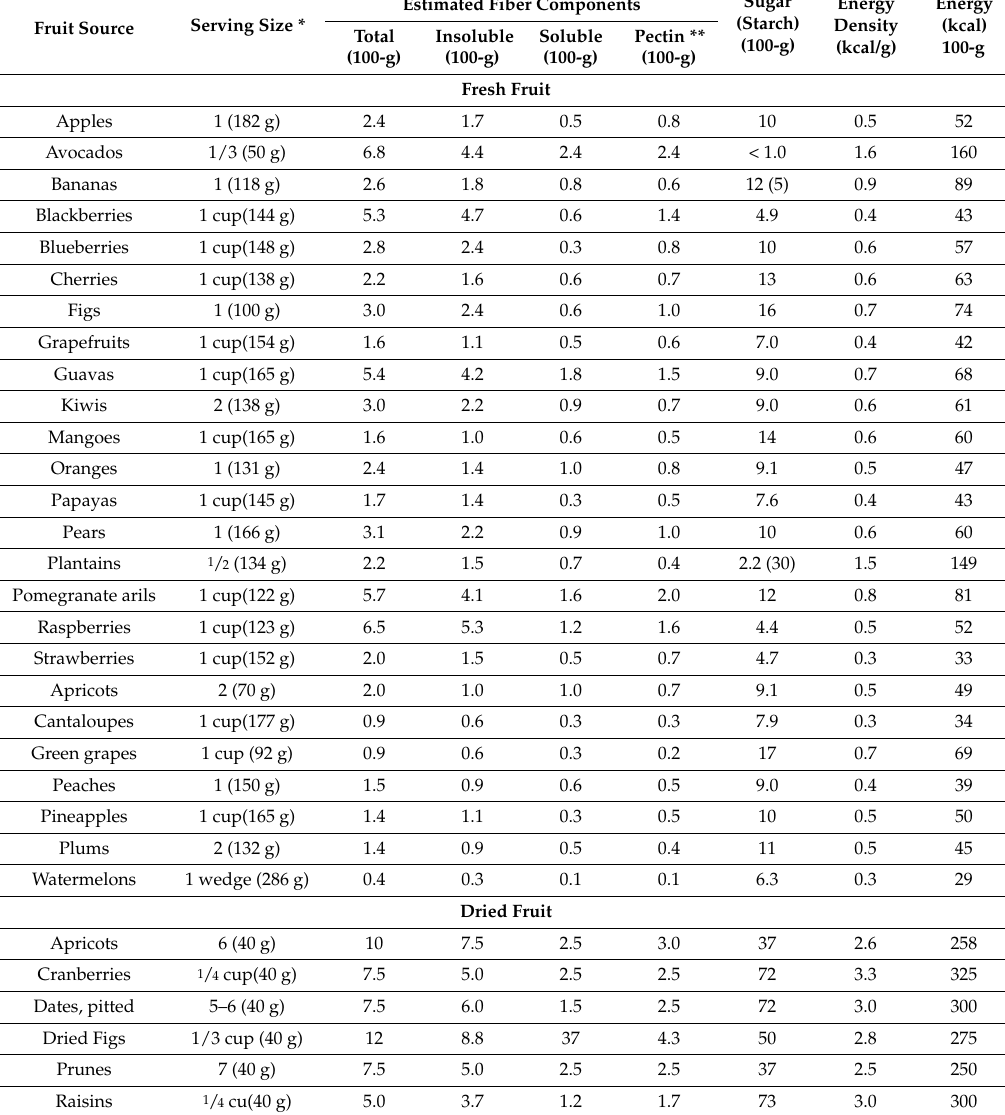
Table 1. Specific whole fruit fiber, available carbohydrates and energy content